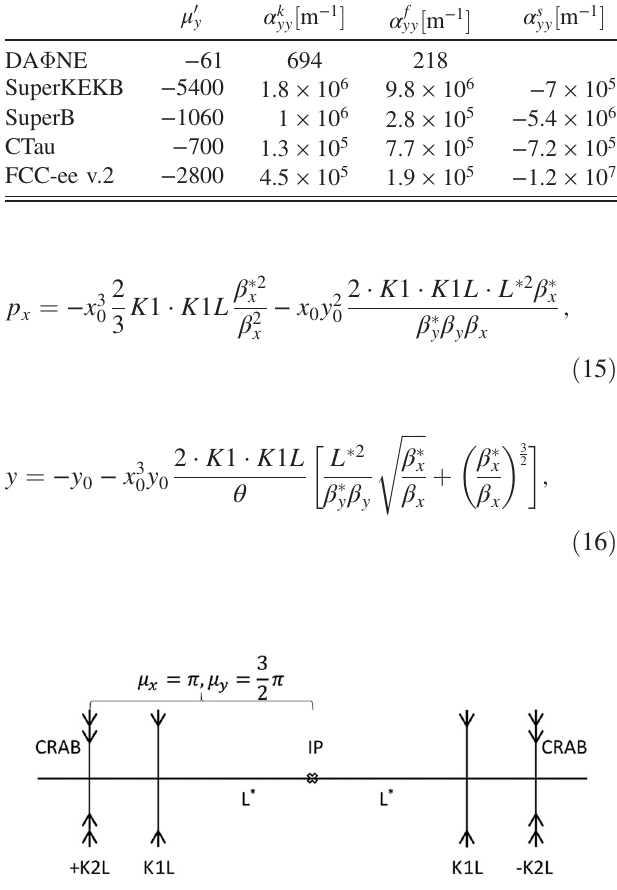
3.FIG. 15. Layout of the simple interaction region.